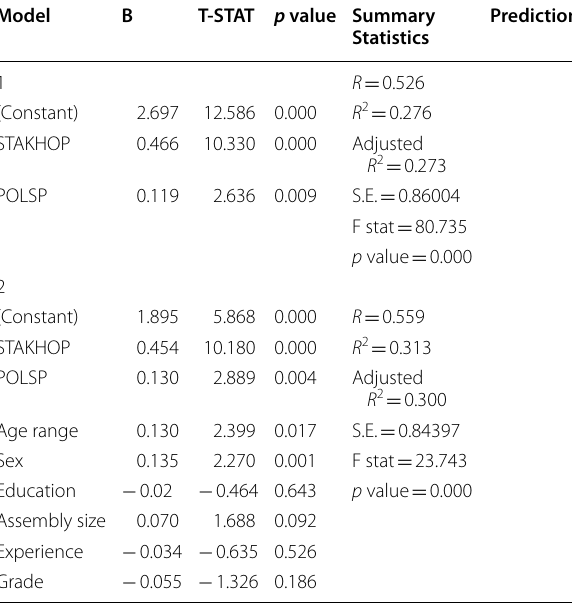
Table 9 Regression results with PM as a dependent